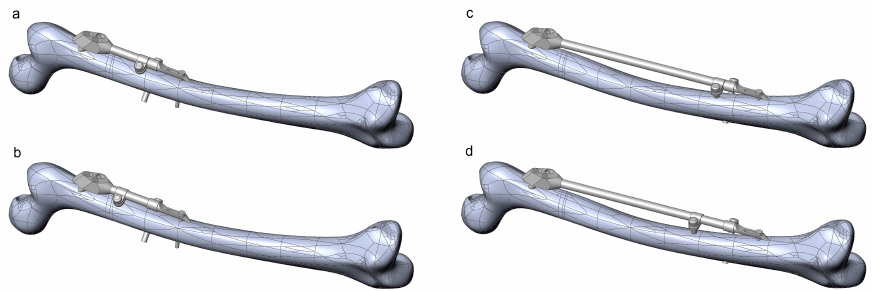
Figure 8. Instances of the femur – SIF assembly created using extreme combinations of design parameters. ( a ) Bar length 100 mm, clamp spacing 1 mm. ( b ) Bar length 100 mm, clamp spacing 28 mm. ( c ) Bar